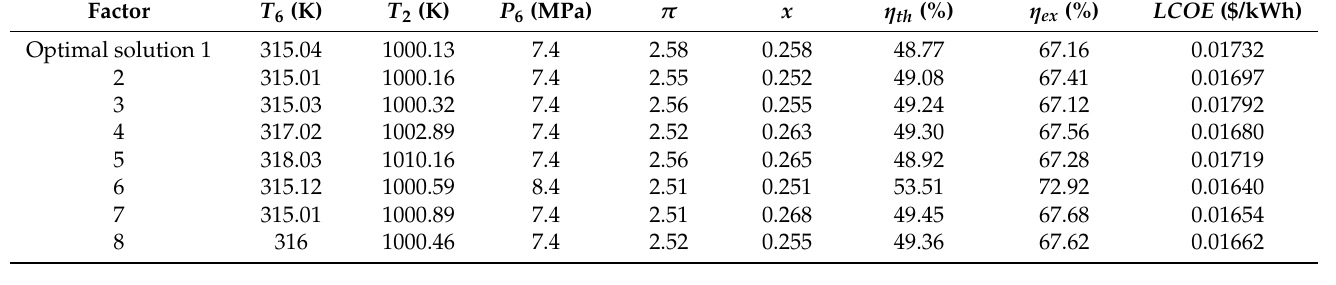
Table 9. Pareto optimal solution for η th , η ex , and LCOE .